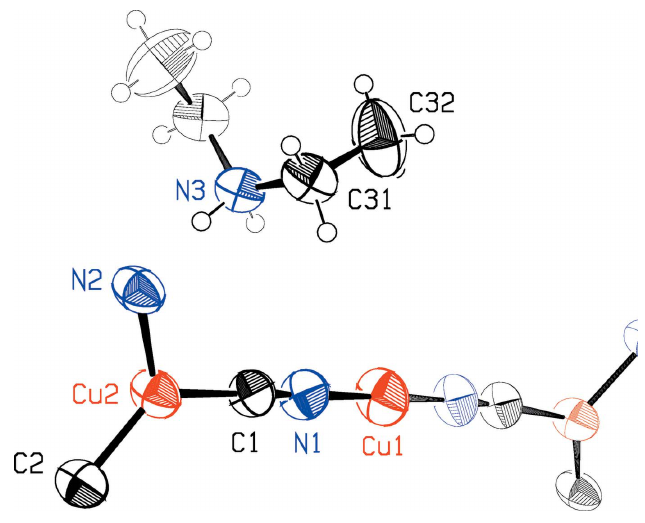
Figure 1 The asymmetric unit of the title compound is emboldened. Different crystallographic twofold axes pass through Cu1 and N3. Displacement ellipsoids are drawn at the 50% probability level, while H atoms are depicted as arbitrary spheres. Cu atoms are colored red, N atoms blue, and C and H atoms